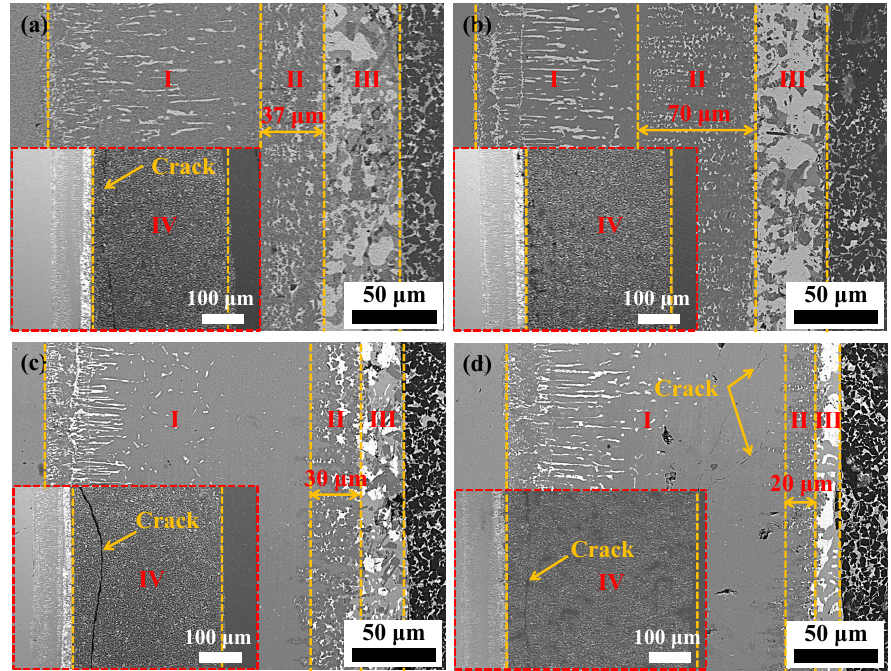
Figure 5. Microstructure of the PS-SiC-stainless steel joints brazed at different temperatures for 15 min: ( a ) 880 °C; ( b ) 890 °C; ( c ) 900 °C; and ( d ) 910 °C.